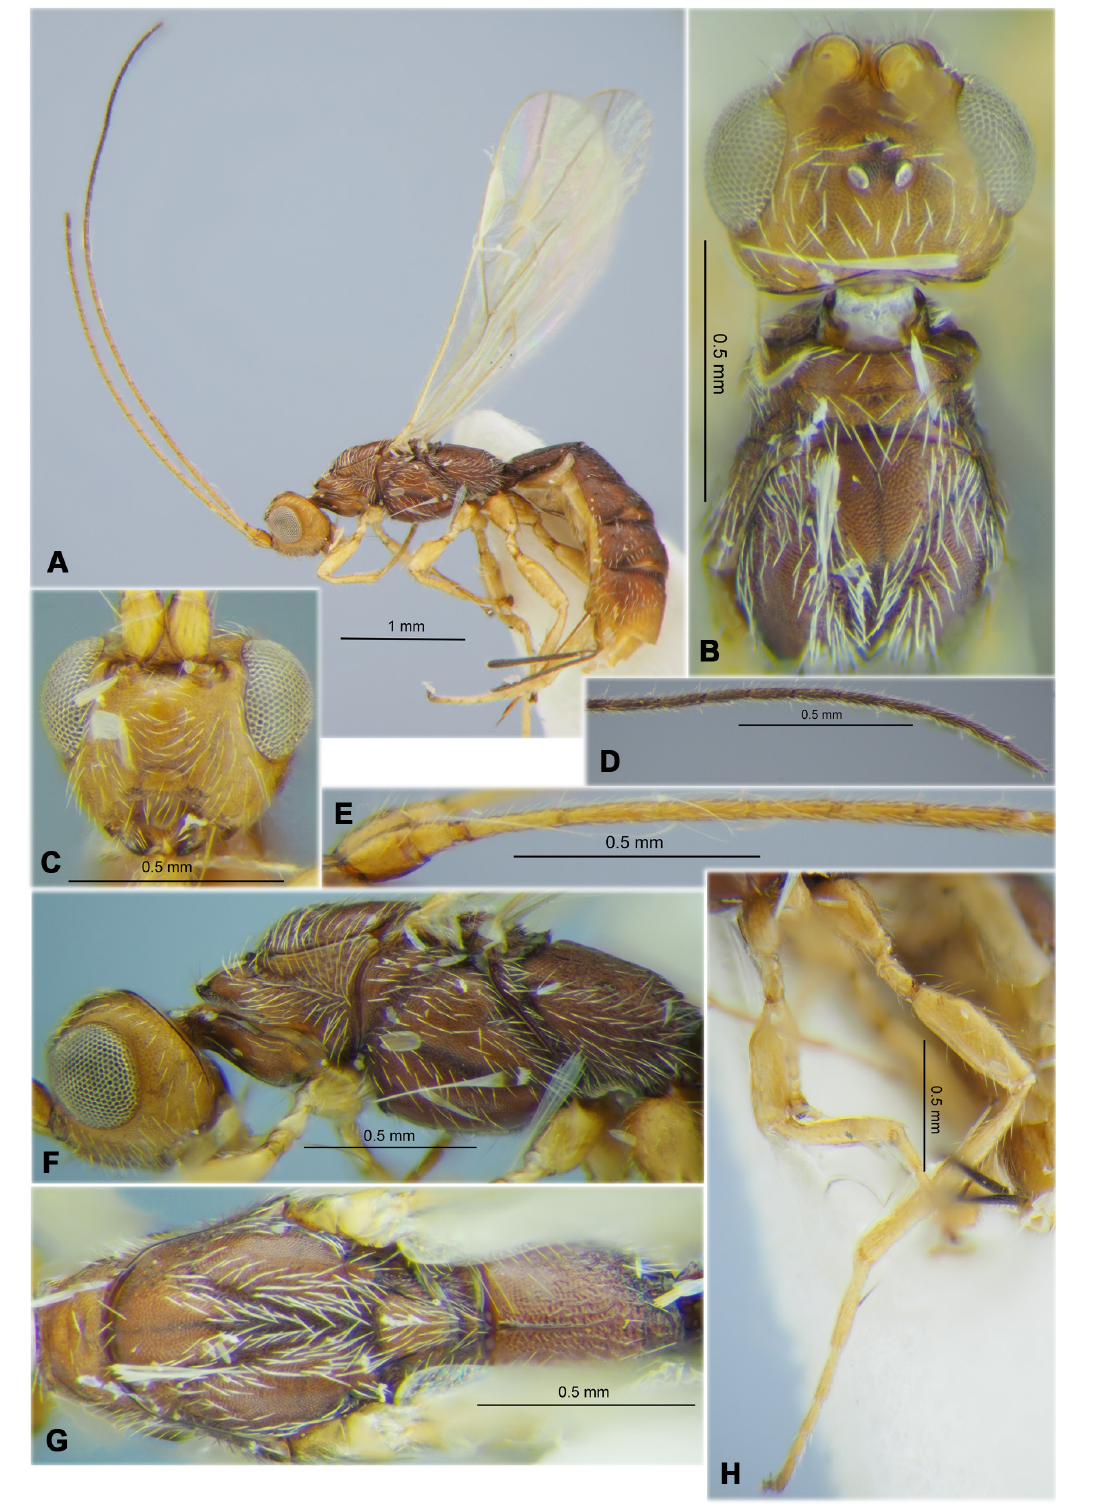
Fig. 53. Rhaconotus ( Rh. ) manolus Nixon, 1941, ♀ (RMNH). A . Habitus, lateral view. B . Head and mesoscutum, dorsal view. C . Head, front view. D . Apical segments of antenna. E . Basal segments of antenna. F . Head and mesosoma, lateral view. G . Mesosoma, dorsal view. H . Hind